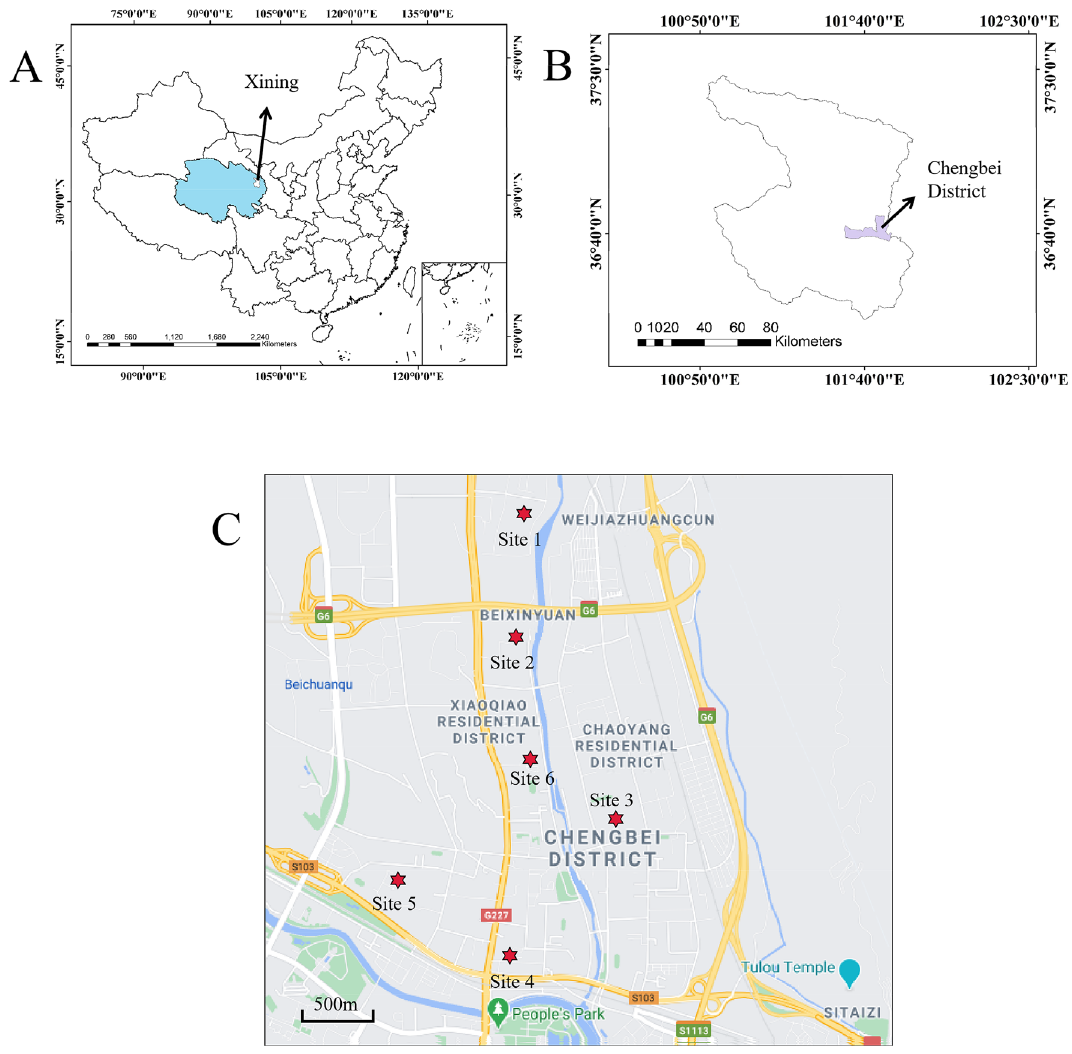
Figure 1. Geographic location of the data collection. Created by Arcgis10.6 (https ://www.arcgi s.com/index .html) and Baidu map15.0. (https ://map.baidu .com).